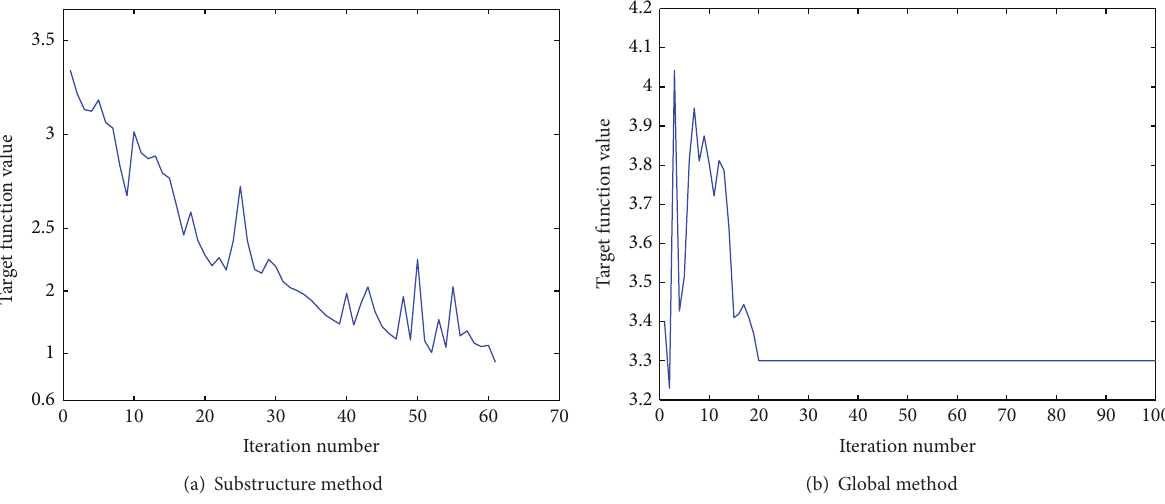
Figure 10: Convergent curves of Case 5.